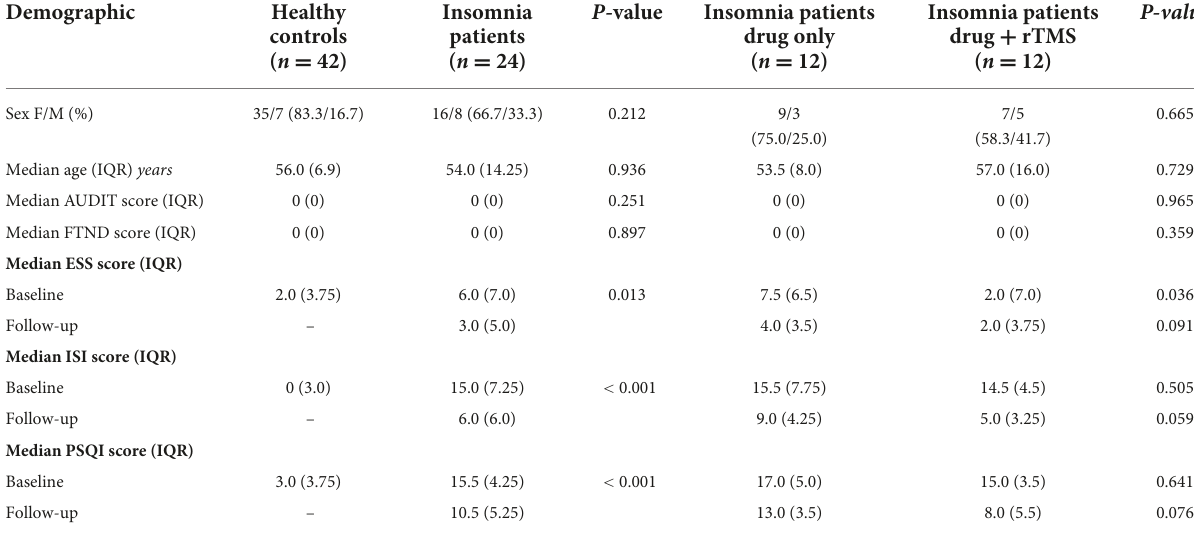
TABLE 2 Baseline and follow-up characteristics for insomnia patients who underwent treatment.